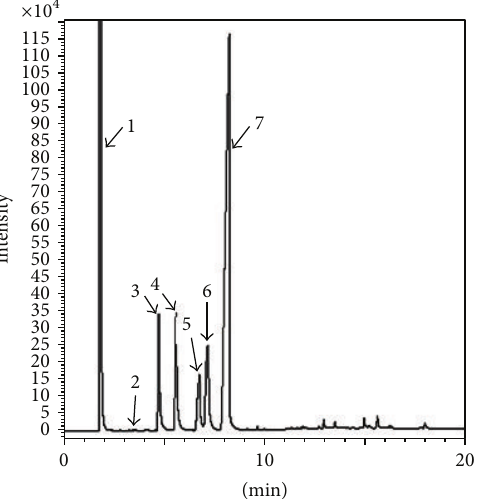
Figure 12: GC chromatogram of the produced CCOME. The peaks 1–7 showed n-hexane (solvent), methyl myristate, methyl palmitate, methyl heptadecanoate (internal standard), methyl stearate, methyl oleate, and methyl linoleate, respectively.